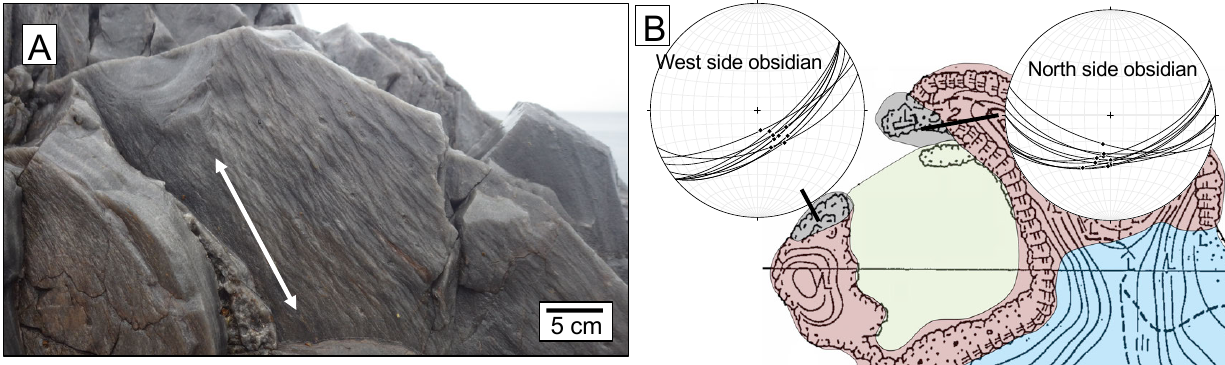
Figure 8: [A] Nearly vertical parallel striations (double arrow) developed on the flattened surface of the platy ob- sidian clasts. [B] Foliation planes and striation rakes of the sheared obsidian clasts plotted on